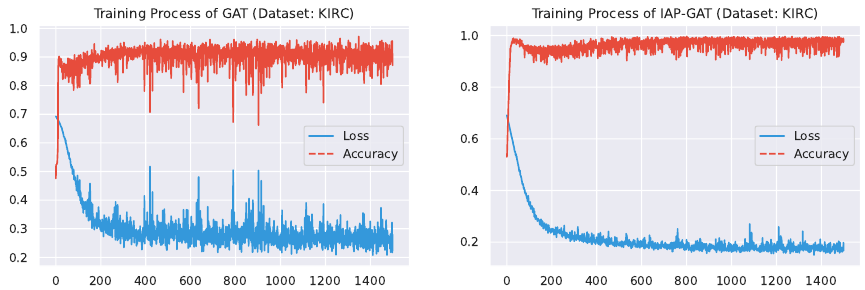
Figure A3. Training process of GAT and IAP-GAT on KIRC dataset.